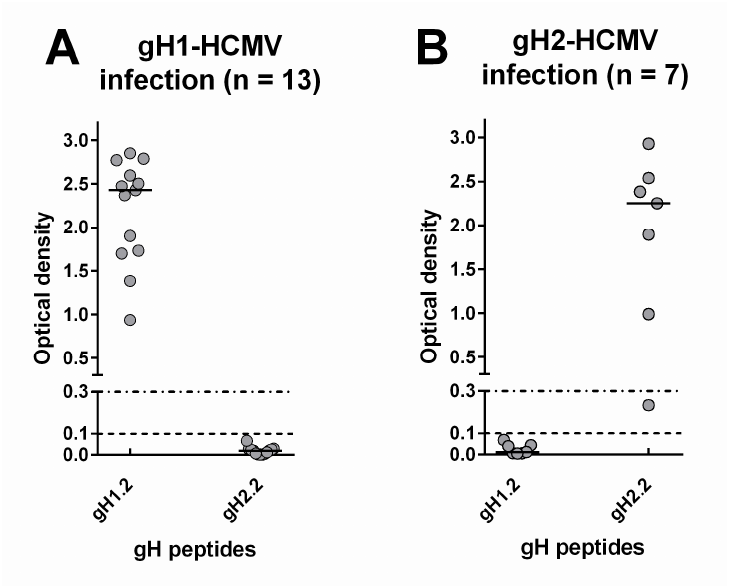
Figure 5. Genotype-specific IgG antibody (OD value) to peptides of the two gH genotypes 1 year after primary HCMV infection. ( A ) IgG response in subjects infected by gH1-HCMV. ( B ) IgG response in subjects infected by gH2-HCMV. Viruses 2021 , 13 , x FOR PEER REVIEW